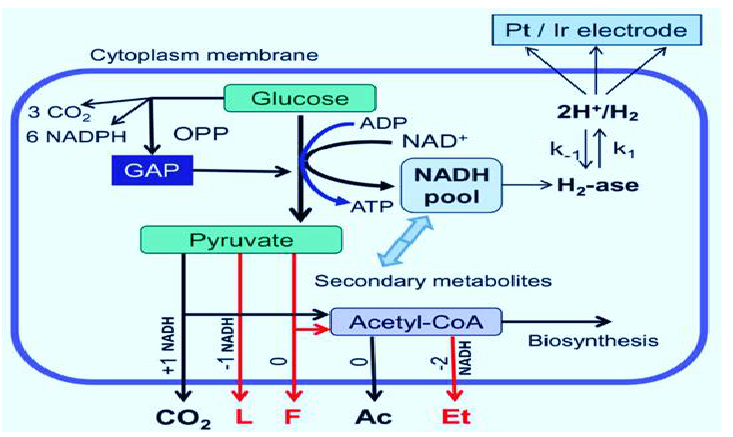
Figure 2. A general schematic representation of hydrogen production under dark fermentation condition in microbes (L: lactate; F: formate; Et: ethanol; Ac: acetate).